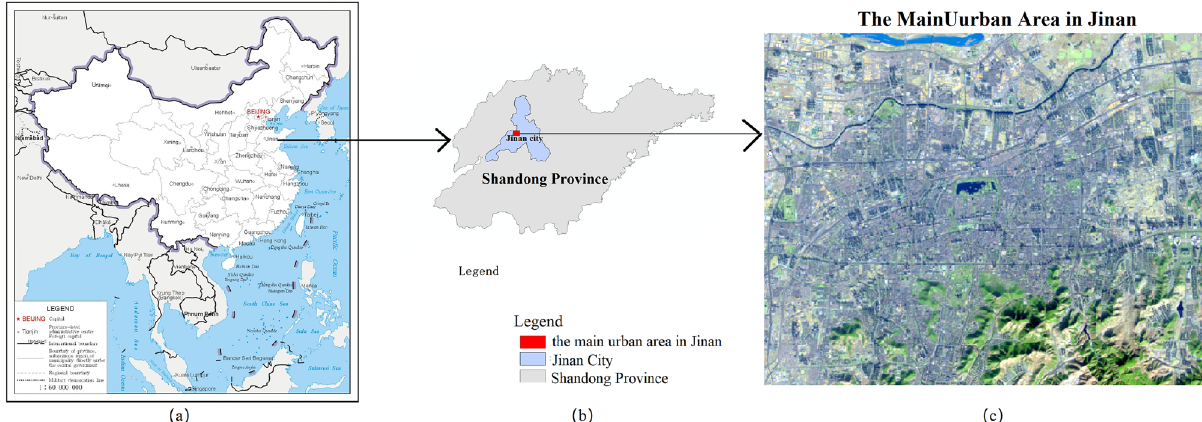
Figure 1. Location of the study area. A is the map of China(http:// bzdt. ch. mnr. gov. cn/ browse. html? picId=% 224o2 8b062 5501a d1301 5501a d2bfc 0291% 22) , and B and C show the location of study area (the main urban area in Jinan) and the Landsat-8 OLI image in study area. Map created in ArcMap 10.5 of the Environmental System Resource Institute, Inc. (https:// www. esri. com/ softw are/ arcgis/ arcgis- for- deskt op). Boundaries made with free vector data provided by National Catalogue Service for Geographic Information (https:// www. webmap. cn/ commr es. do? method= dataD ownlo